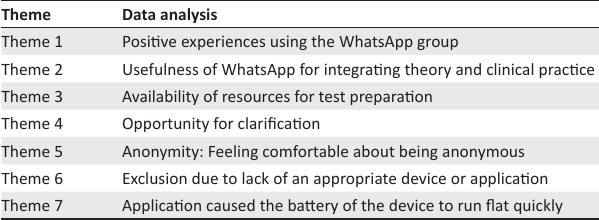
TABLE 2: Main themes